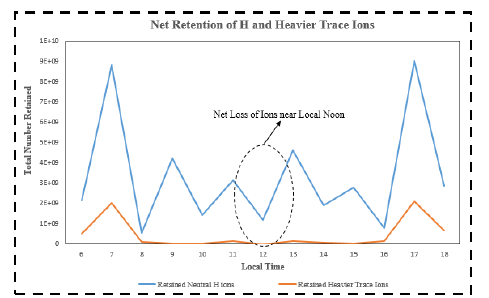
Figure 4. Total retained H and heavier trace ions as a function of T L . This describes the scenario of the simulated lunar regolith with some defects which correlates with the intrinsic mineralogy responsible for crystal strength.